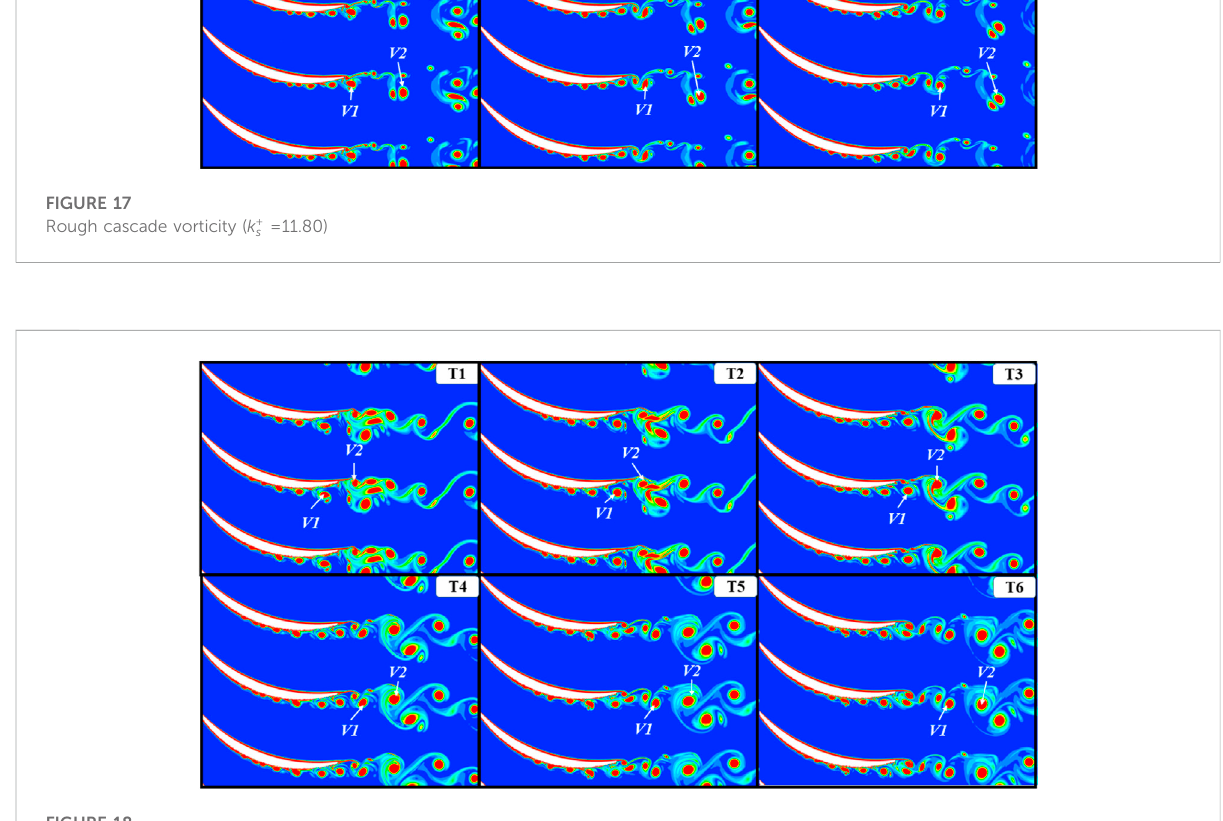
FIGURE 18 Rough cascade vorticity ( k + s